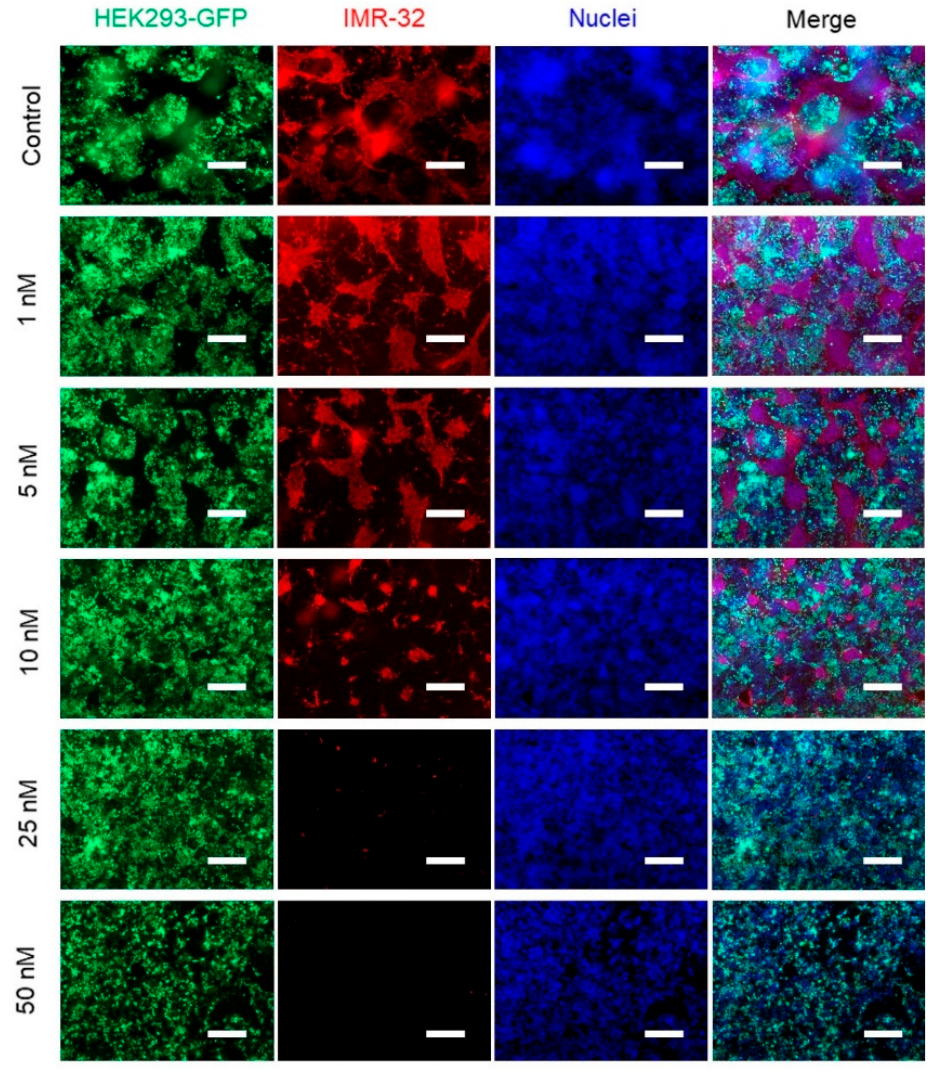
Figure 5. Co-culture of HEK29-GFP cells and IMR-32 cells in monolayer treated with panobinostat visualized by expressed GFP and immunofluorescence staining of GD2. HEK293-GFP cells and IMR-32 cells (1:1) at a total density of 10 4 /well were seeded in 96-well plate and dosed with panobinostat at the indicated concentrations for 72 h. HEK293-GFP cells (green) expressed GFP while IMR-32 (red) cells were labeled by GD2 immunofluorescence staining. The nuclei were all stained with DAPI in blue. All images were taken at the same magnification; scale bar, 250 µm.